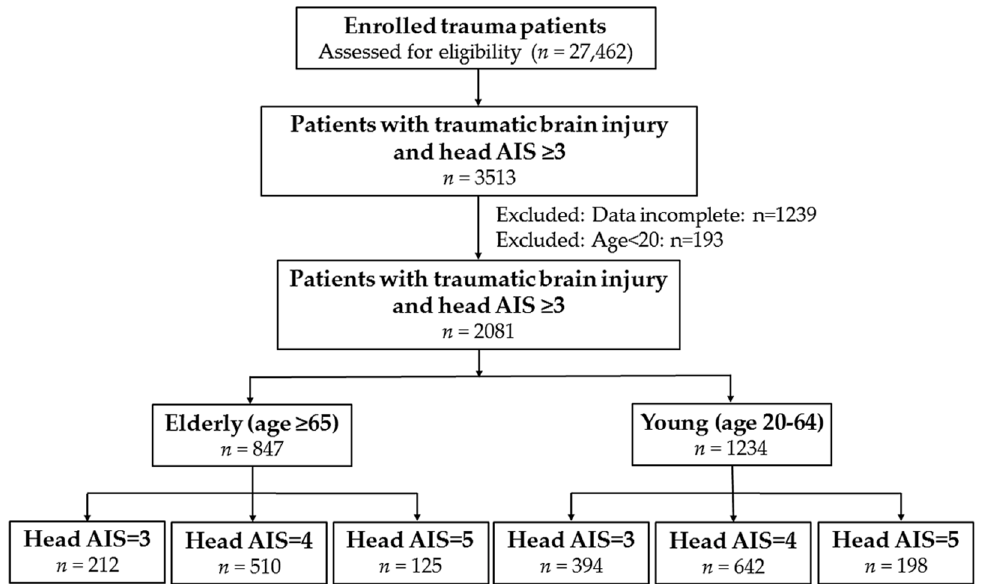
Figure 1. Flowchart on the allocation of patients with moderate and severe traumatic brain injuries into six exclusive groups according to age and head AIS scores.